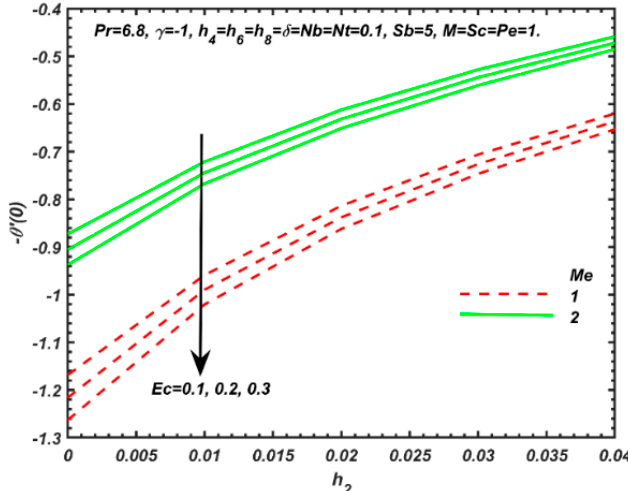
Figure 9. Local Nusselt number, (0) θ′− versus 2 h and Me for different values of Ec .